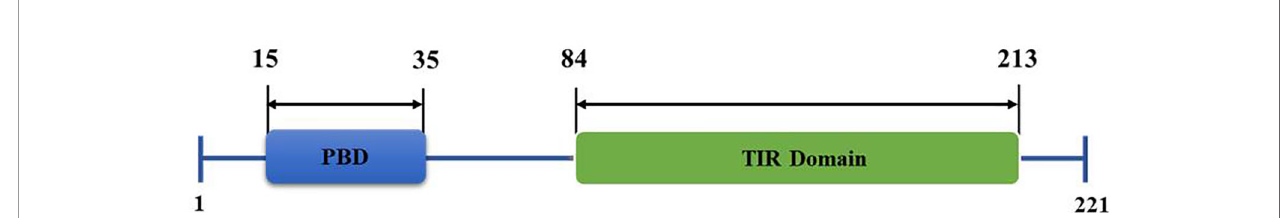
FIGURE 1 | Structural organization of Toll/interleukin 1 receptor (TIR) domain-containing adaptor protein (TIRAP) domains. The amino acid position of an N-terminal phosphatidylinositol (PI) binding domain (PBD) and a C-terminal Toll-like receptor (TIR) domain are as